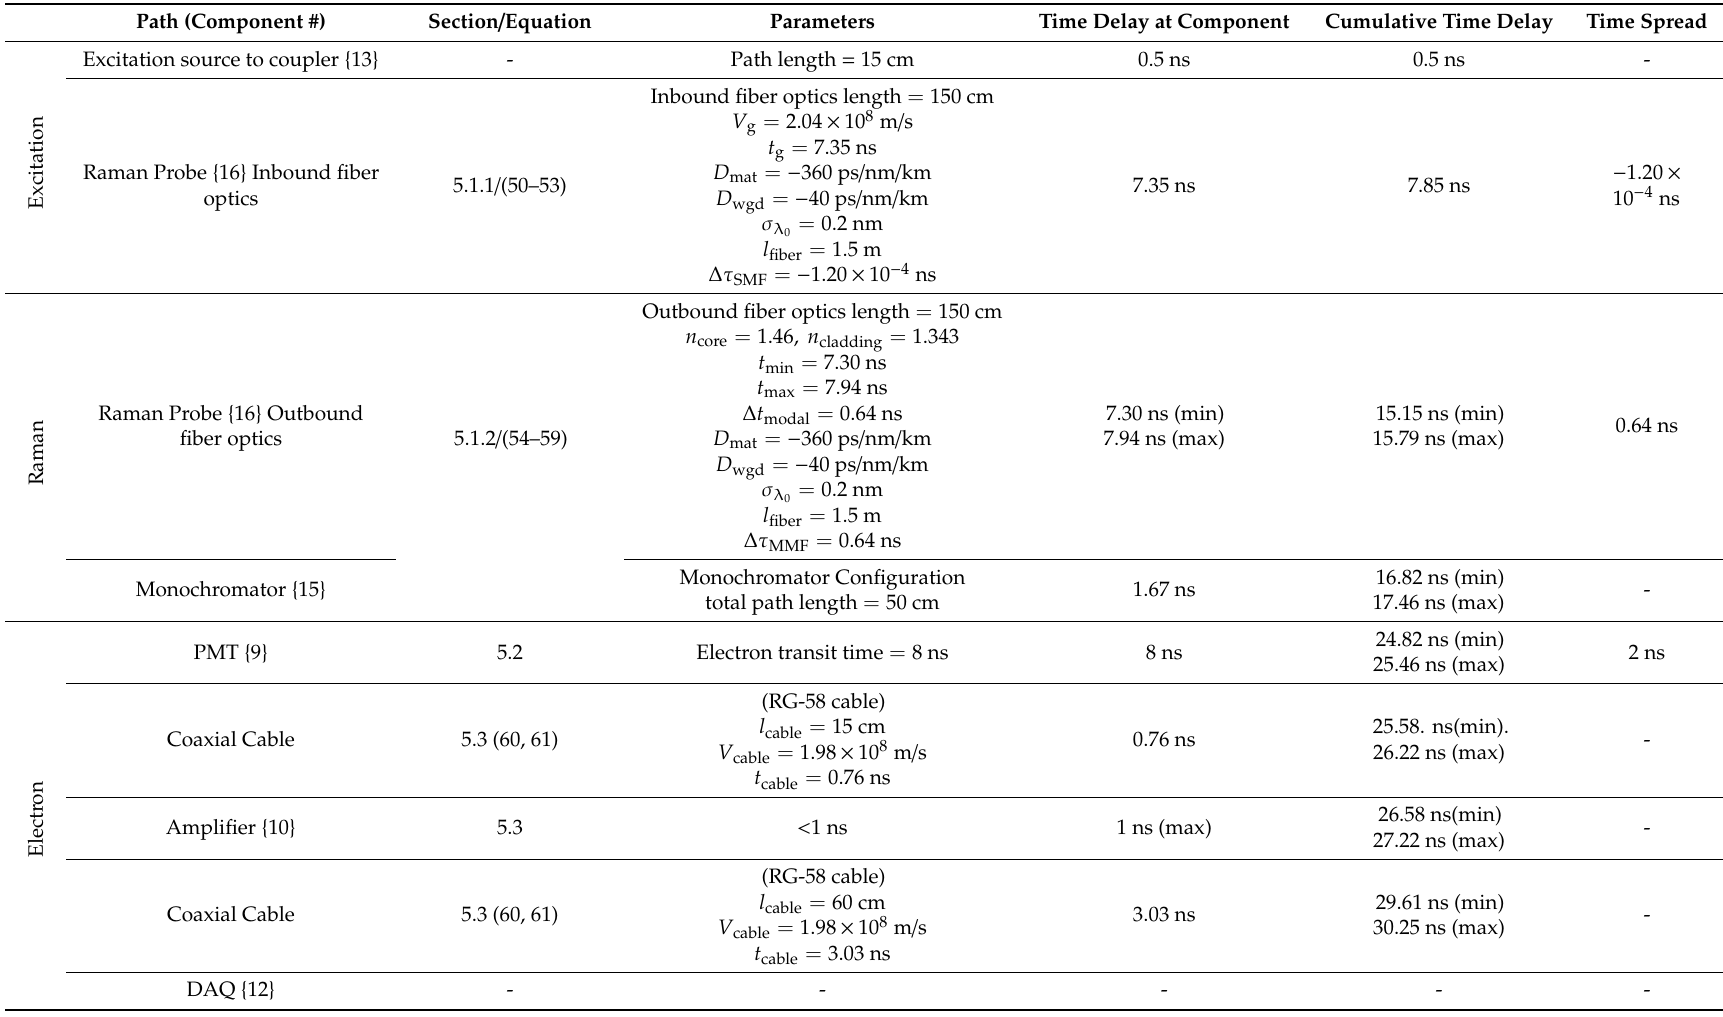
Table 11. Purdue CE Spectroscopy Lab 532 nm closed-path TRRS example time